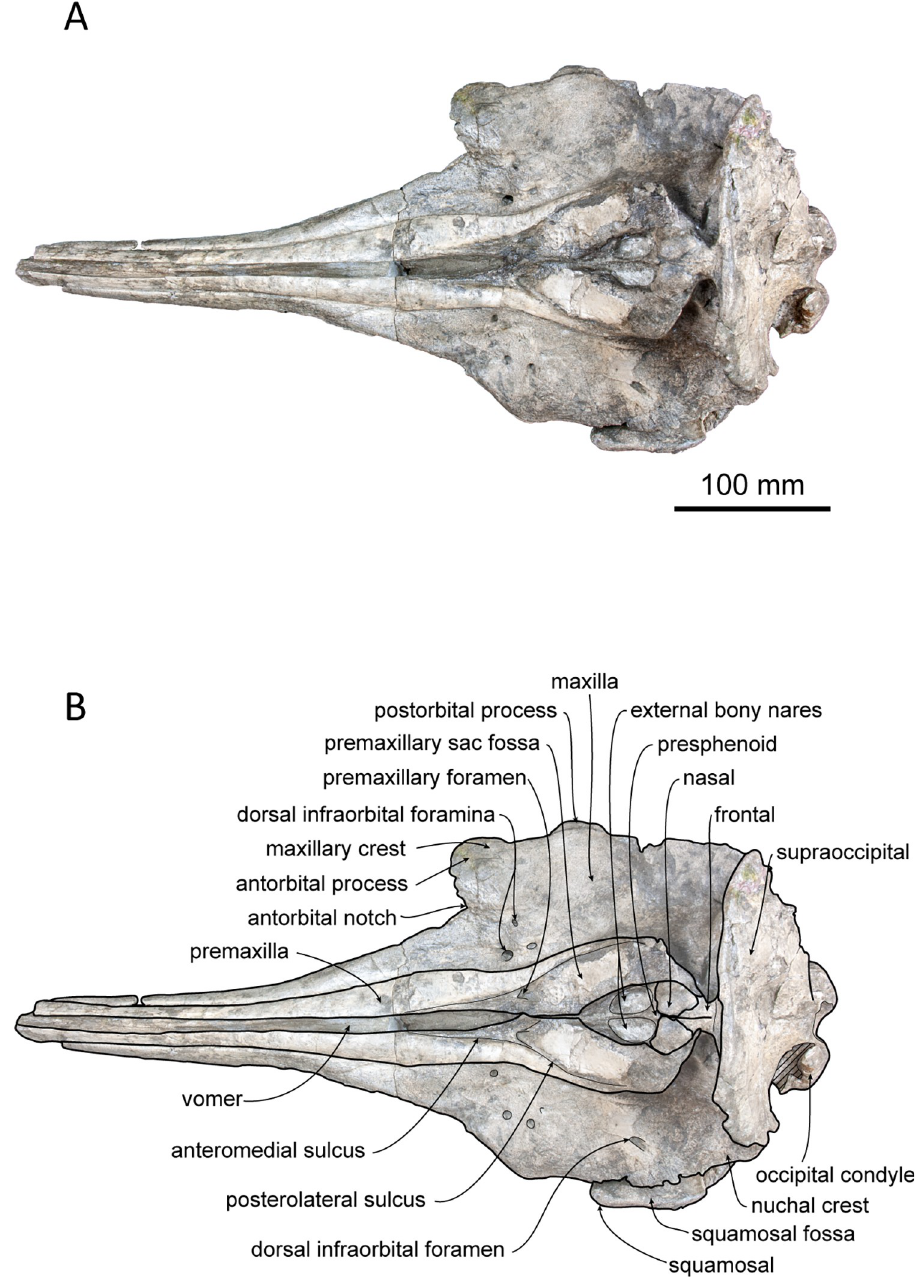
Fig 2. Dorsal view of the skull of Platysvercus ugonis gen. et sp. nov., holotype, UTHFM 00034. (A) photo. (B) corresponding line drawing with anatomical interpretations. Scale bar equals 100 mm. Diagnosis of Species. It differs from other species within the family in having a unique combination of the characters: the premaxillary foramen located laterally from the midpoint to the premaxilla (character 70), the premaxillae raised up towards the midline but concave transversely between the anteromedial sulci emanating from the premaxillary foramen (char- acter 121), and the anterior margin of the pterygoid sinus fossa located posterior to the antor- bital notch (character 190).